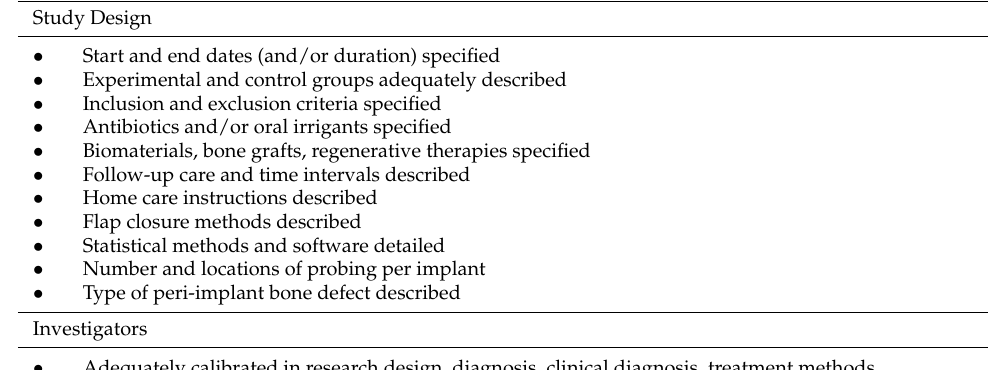
Table 9. Recommendations for future